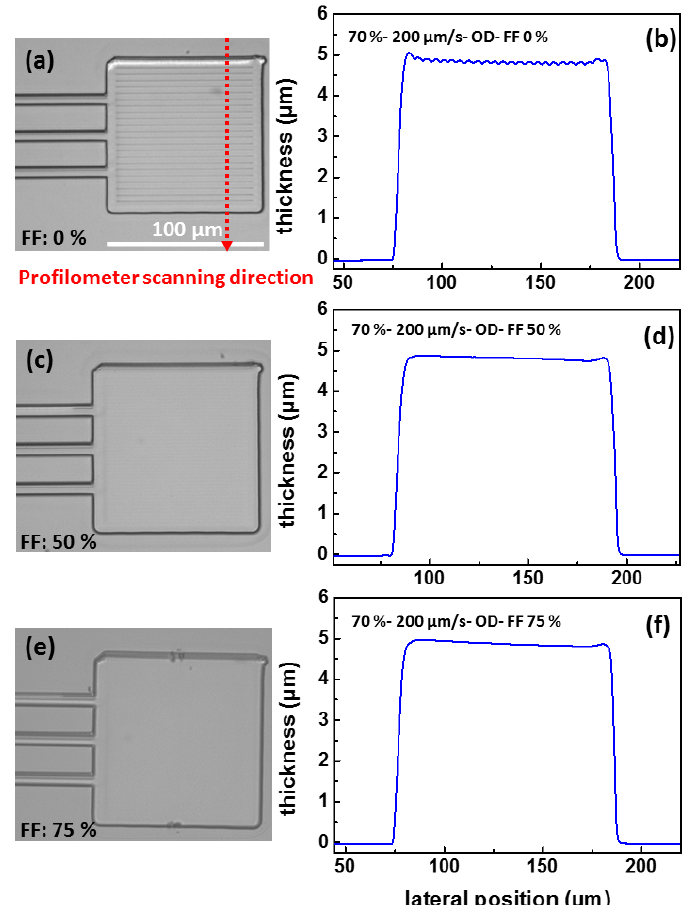
Figure 8. Influence of the filling factor (FF), ranging from 0% to 75% on the shape of TiO 2 –SiO 2 MMI- like structures (square shape and three waveguides with a 6 µm lateral dimension). ( a ) Microscope images (× 40) of an MMI-like structure obtained with an FF of 0%, ( b ) corresponding profile, ( c ) MMI at an FF of 50%, ( d ) corresponding profile, ( e ) MMI at an FF of 75%, and ( f ) corresponding profile.